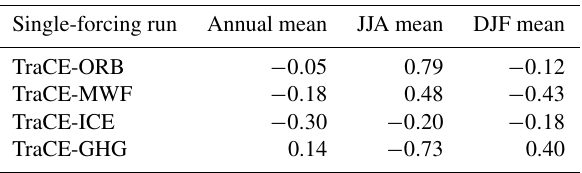
Table 2. Correlation coefficients between the annual mean and sea- sonal mean NHTs derived from the TraCE-ALL run and those from each single-forcing run from 5.0 to